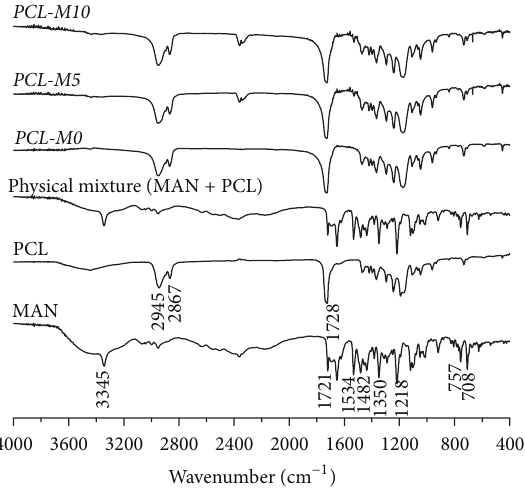
Figure 5: FTIR spectra of MAN, PCL, physical mixture (MAN + PCL), and PCL microparticles.